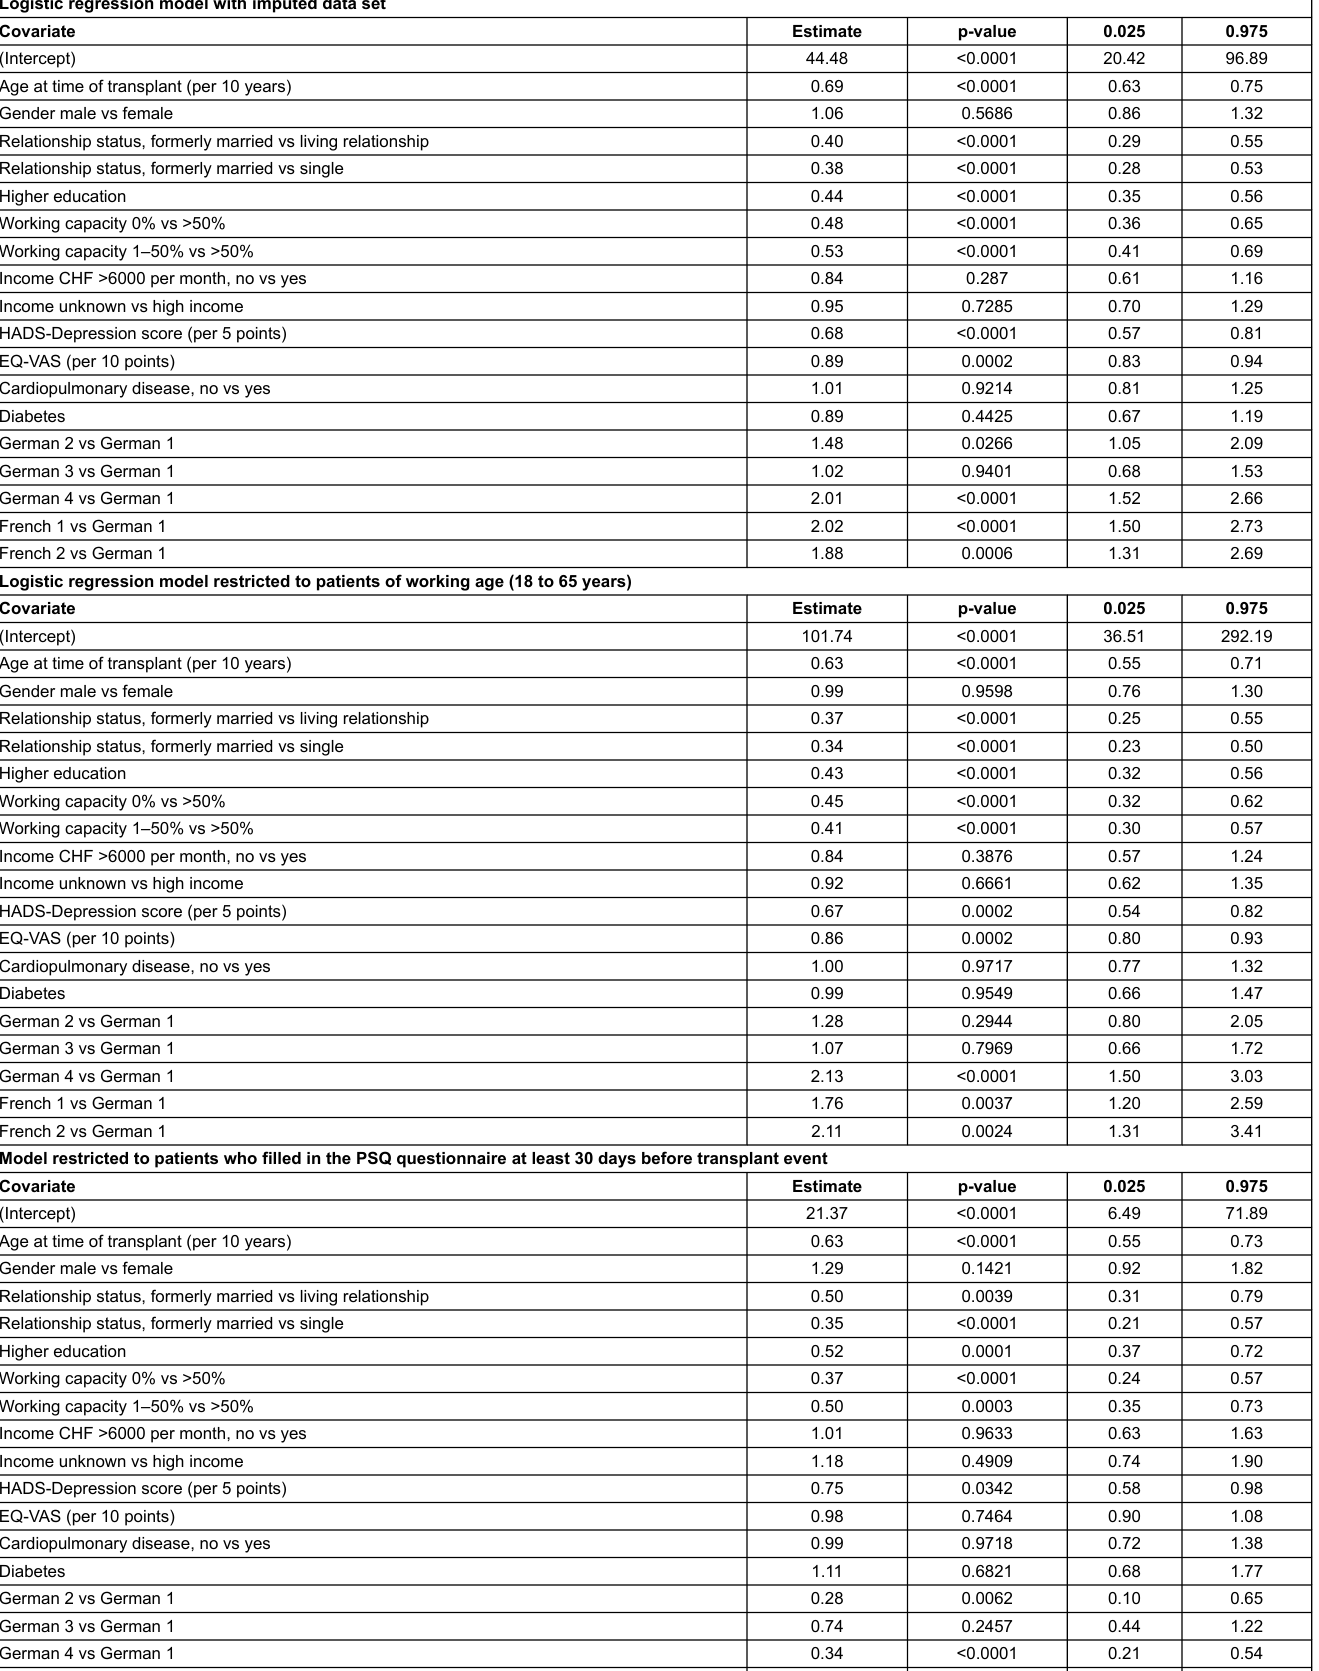
Table S1: Results of the logistic regression model for the imputed data set, subgroup restricted to recipients of working age 18–65, and subgroup of recipients who filled in the PSQ questionnaire at least 30 days or at least 180 days before the transplant event. Logistic regression model with imputed data